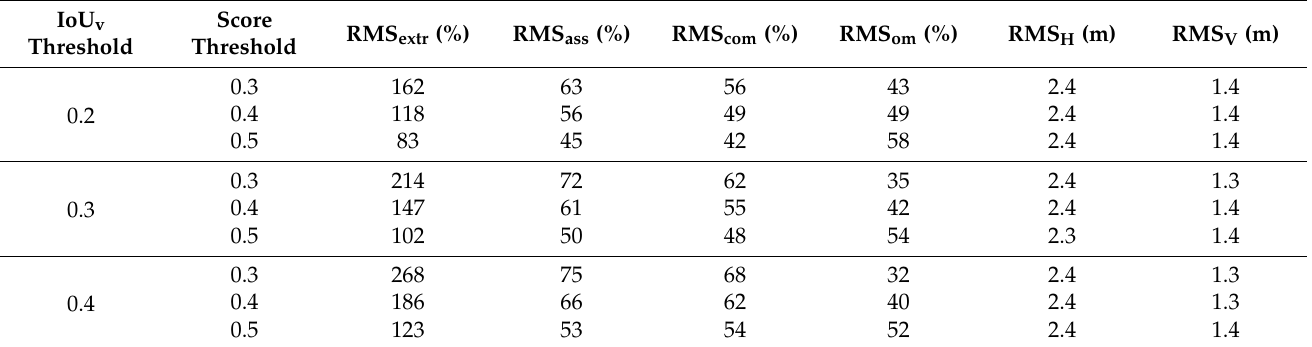
Table 4. Detection performance of Tree RCNN with different IoUv thresholds and score thresholds for all